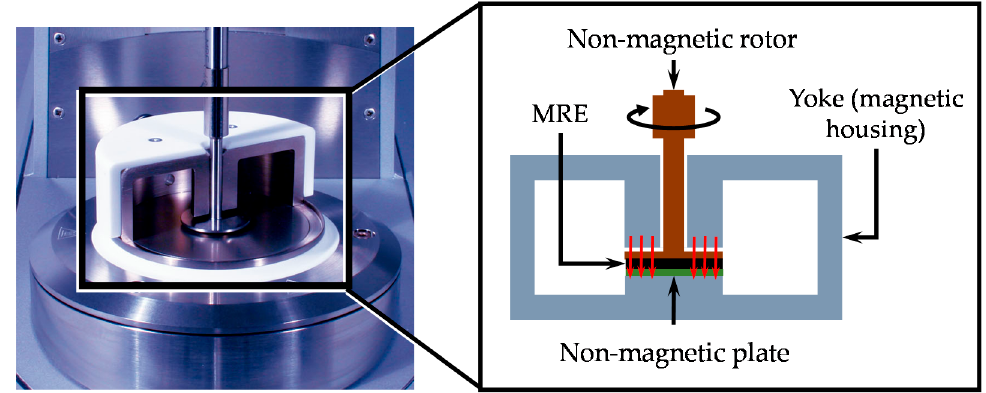
Figure 1. Diagram of the magnetorheological measuring cell. The MRE sample is placed between the bottom plate and the rotor, both made of a non-magnetic material.